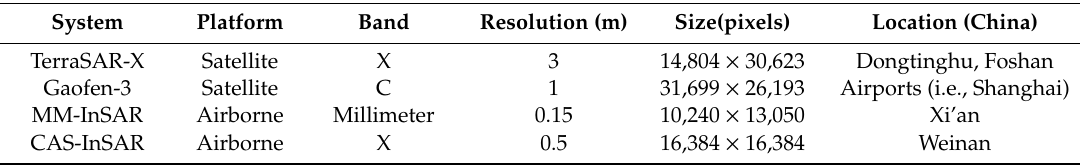
Table 1. SAR image datasets used in this